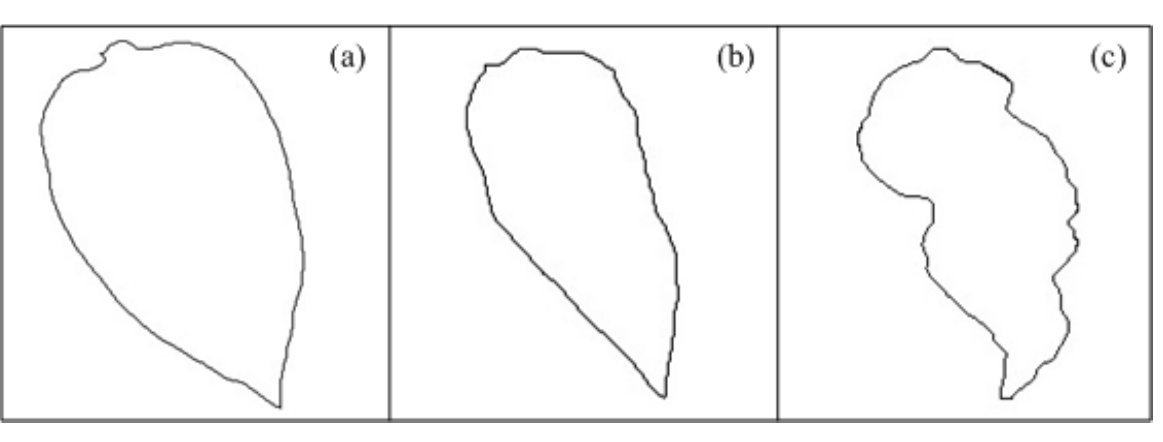
Figure 3. ( a ) Contour of healthy pepper leaf. ( b ) Contour of pepper leaf with low deformation. ( c ) Contour of pepper leaf with severe deformation.